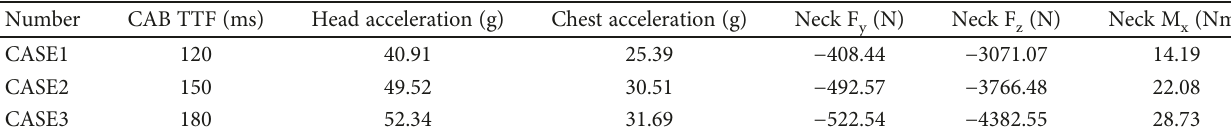
Table 1: Occupant injury indexes with di ff erent CAB TTFs.